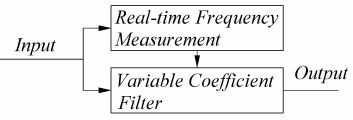
Figure 3. Block diagram of the preprocessing